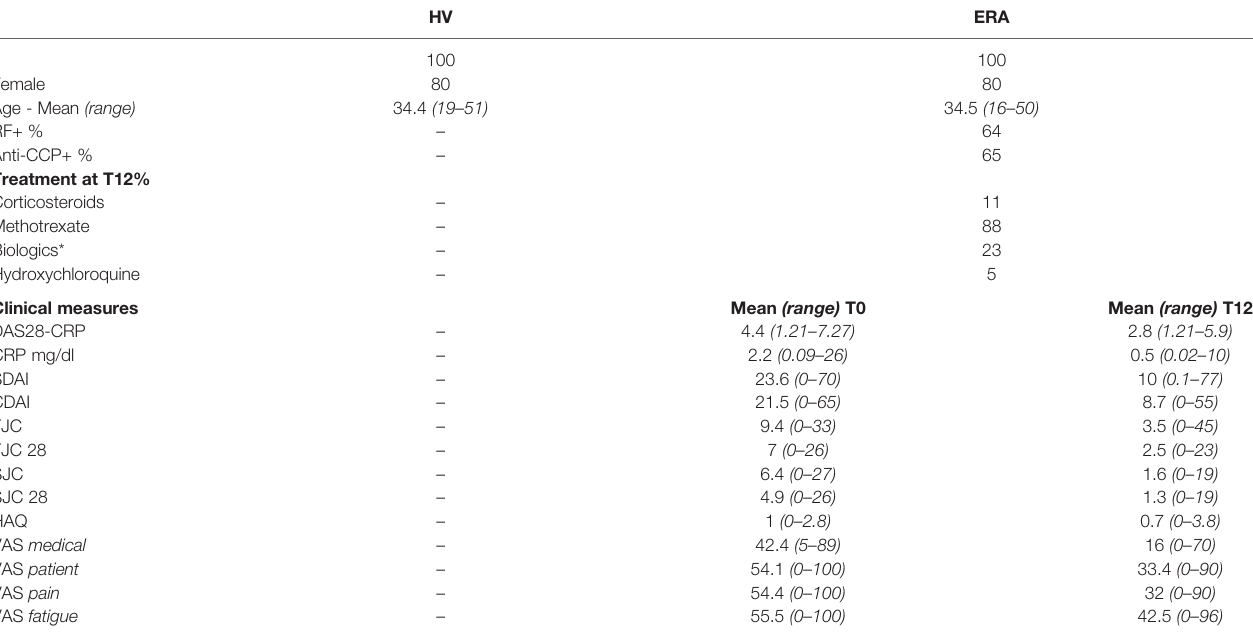
TABLE 1 | Clinical characteristics of